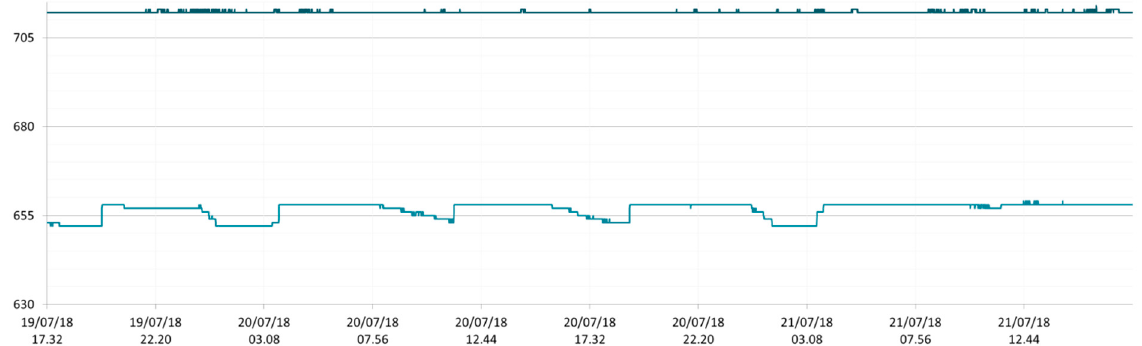
Figure 4. Graph continuously calculated by SmartShell software with the X -axis showing “time” and the Y -axis showing “valve opening”. Each mollusc (named with code “HUBxx-xx) has a distinct pattern highlighted with specific colours, dark blue and light blue.